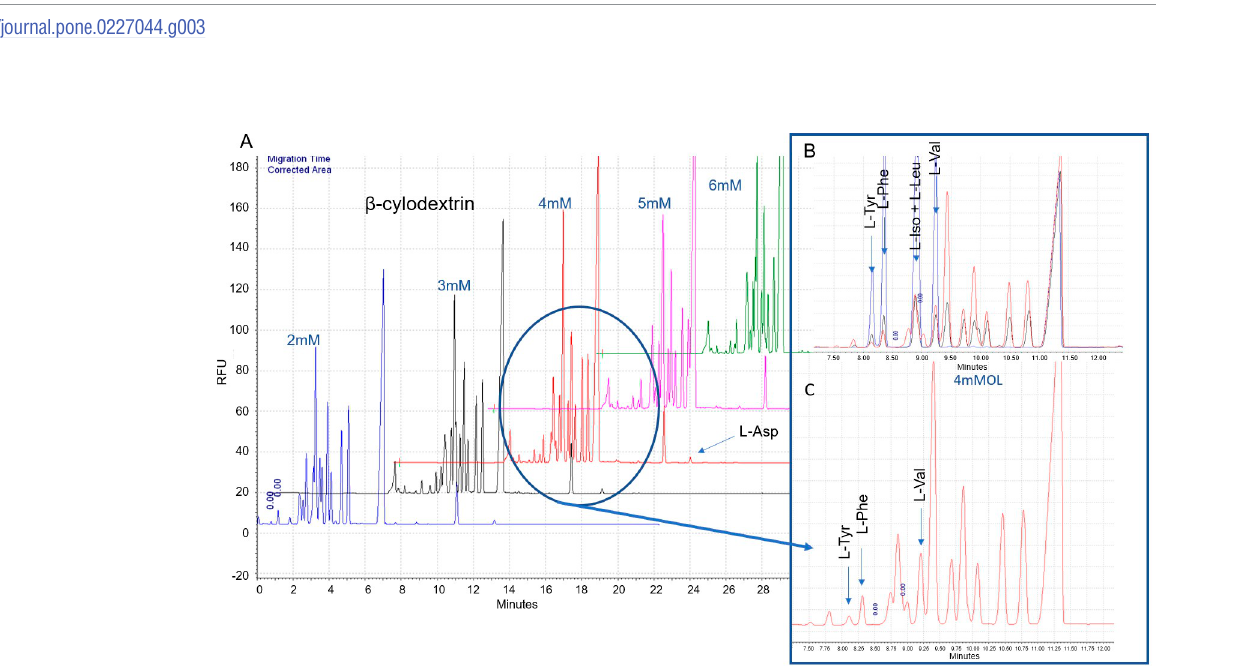
Fig 4. Optimization of L-Tyr, L-Phe, L-Val and L-Asp assessment. (A) Electropherograms of the optimization of the concentration of β -CD in running buffer. (B) Detail of the separation achieved with 4 mM β -CD: (C) Superposition of electropherograms: red, plasma sample; black, mix of 21 amino acids (100 mM) and blue, L-Tyr, L-Phe, L-Iso, L-Leu and L-Val. (0.5 mM).